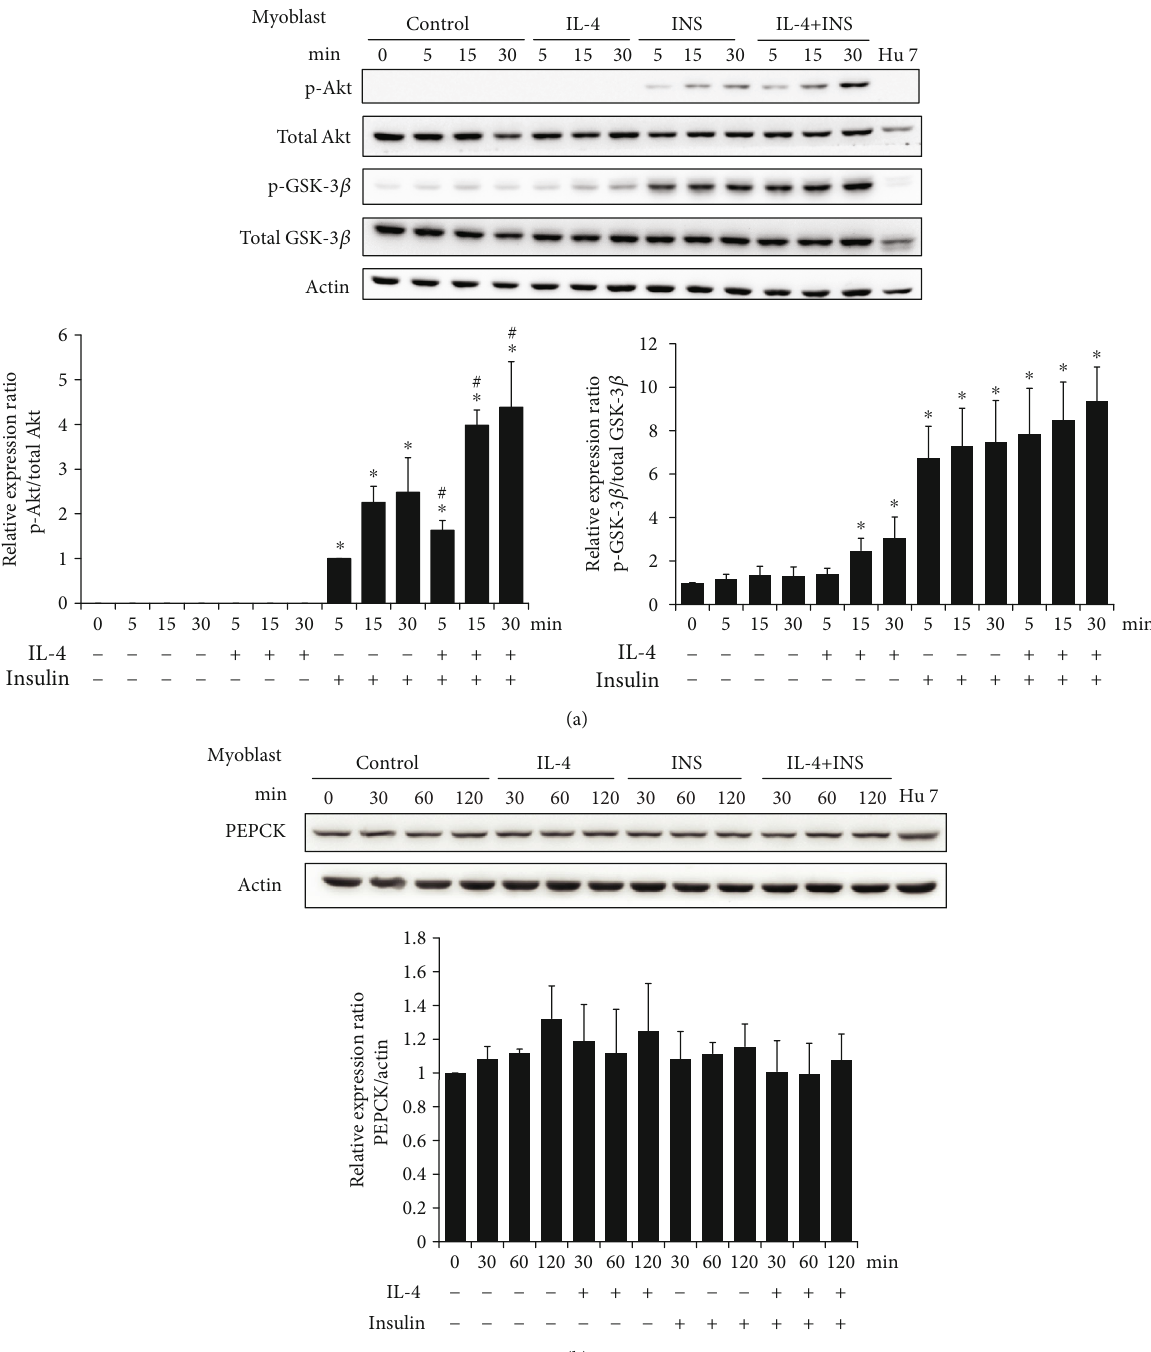
Figure 3: IL-4 boosts insulin signaling in C2C12 myoblasts. Cells were transferred to serum free medium for 3hr, followed by exposure to IL-4 and/or insulin for 30min. (a) Cell lysate were harvested at indicated time, and p-Akt and p-GSK-3 β were analyzed (n =3). (b) Cells were transferred to KRPH bu ff er for 3hr, and cellular glucose uptake was measured as described in Methods (n =3). ∗ p < 0 : 05 v.s 0min, # p < 0.05 v.s INS group at the same time